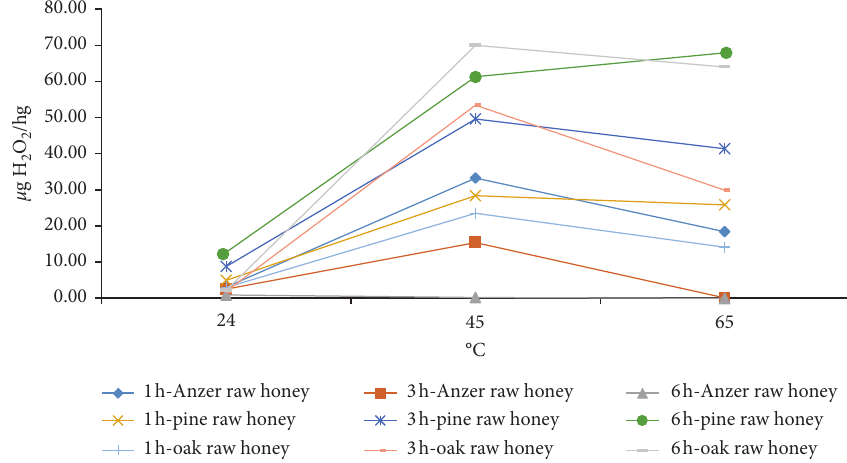
Figure 2: The glucose oxidase activity changing under the timing and heating